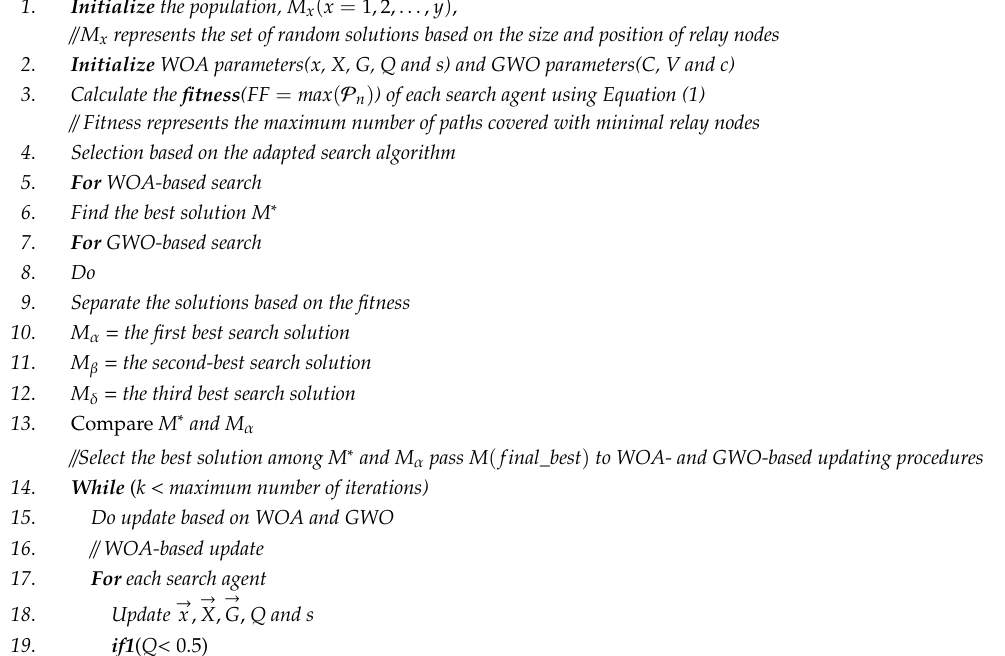
Algorithm 1 W-GUN: Whale-centric Optimization for Green Underwater